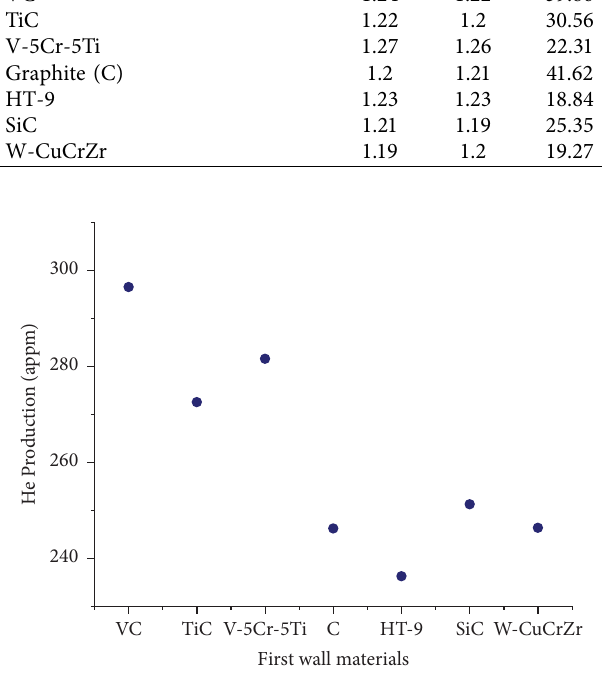
Figure 13: Helium production in each candidate FW materials.